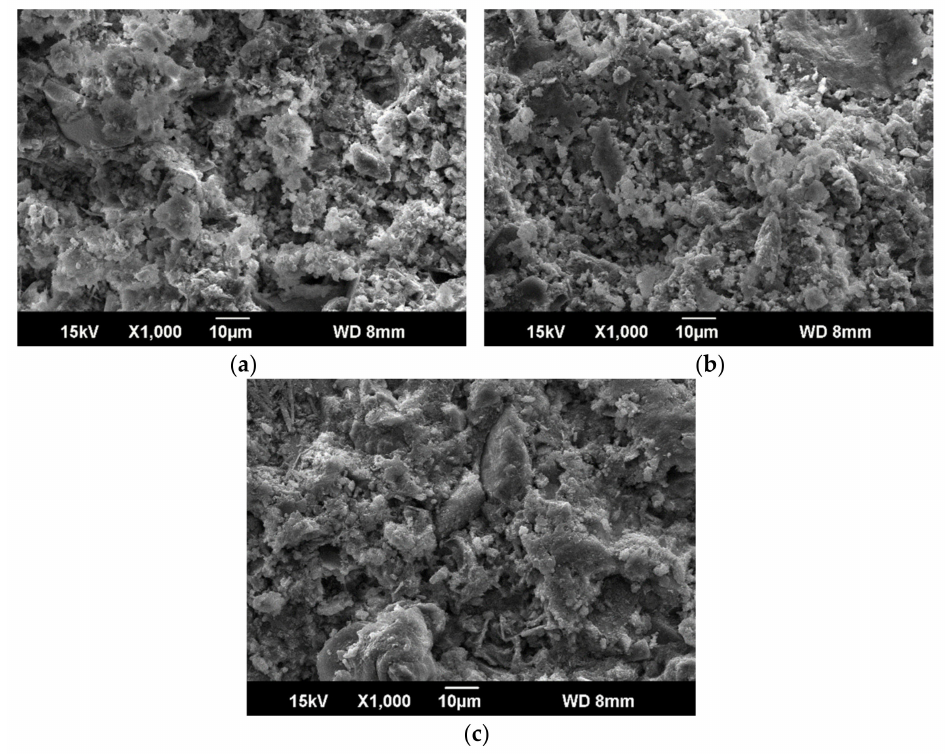
Figure 10. SEM (Scanning Electron Microscopy) of e-1 grout with different curing age. ( a ) Preserved for 3 days; ( b ) preserved for 7 days, and ( c ) preserved for 28